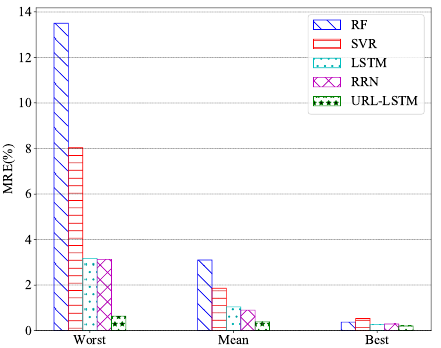
Figure 9. The comparison of the MRE range.